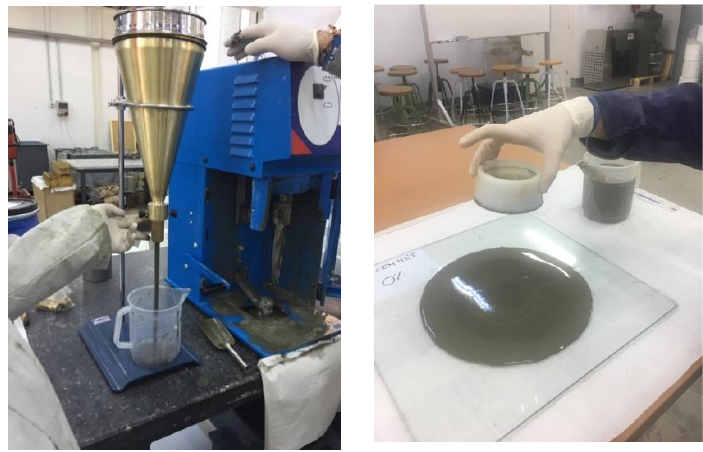
Figure 3. Marsh cone test and grout spread test for fluidity measurements.